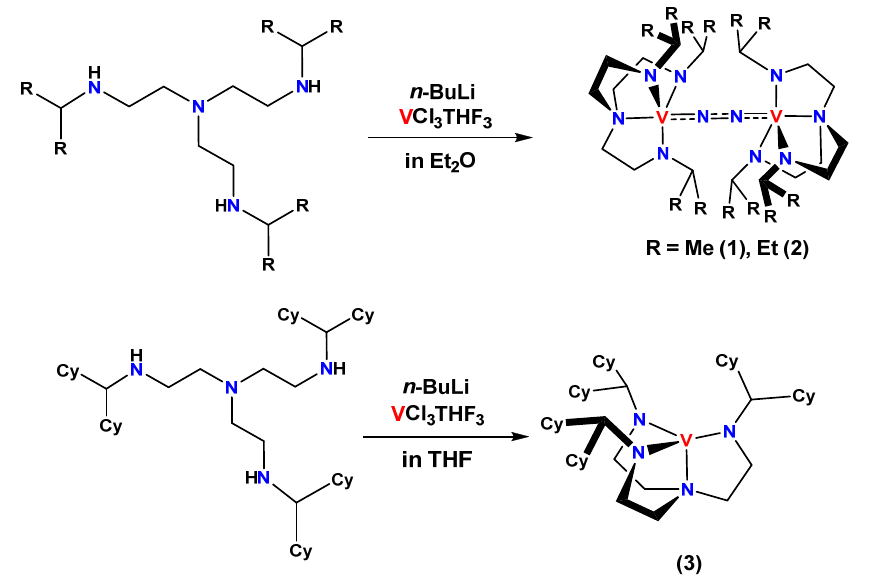
Figure 1. The structures of our previously reported divanadium–dinitrogen complexes [[{V( L R )} 2 ( μ - N 2 )] ( top ) and space-filling models of two dinitrogen complexes [{V( L R )} 2 ( μ -N 2 )] (R = iBu and MeBn) ( bottom ). The hydrogen, nitrogen, and vanadium atoms are shown in white, blue, and green, re- spectively. Secondary carbon atoms on the terminal N atoms are red, and the other carbon atoms are